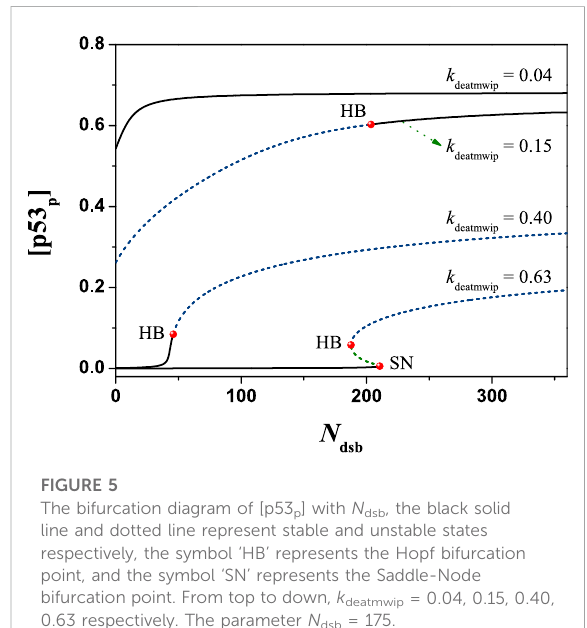
The bifurcation diagram of [p53 p ] with N dsb , the black solid line and dotted line represent stable and unstable states respectively, the symbol ‘ HB ’ represents the Hopf bifurcation point, and the symbol ‘ SN ’ represents the Saddle-Node bifurcation point. From top to down, k deatmwip = 0.04, 0.15, 0.40, 0.63 respectively. The parameter N dsb =